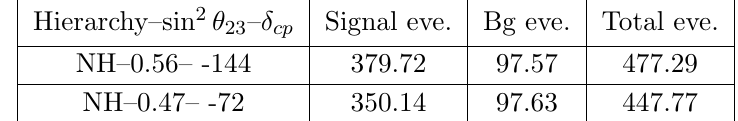
Hierarchy{sin 2 (cid:18)